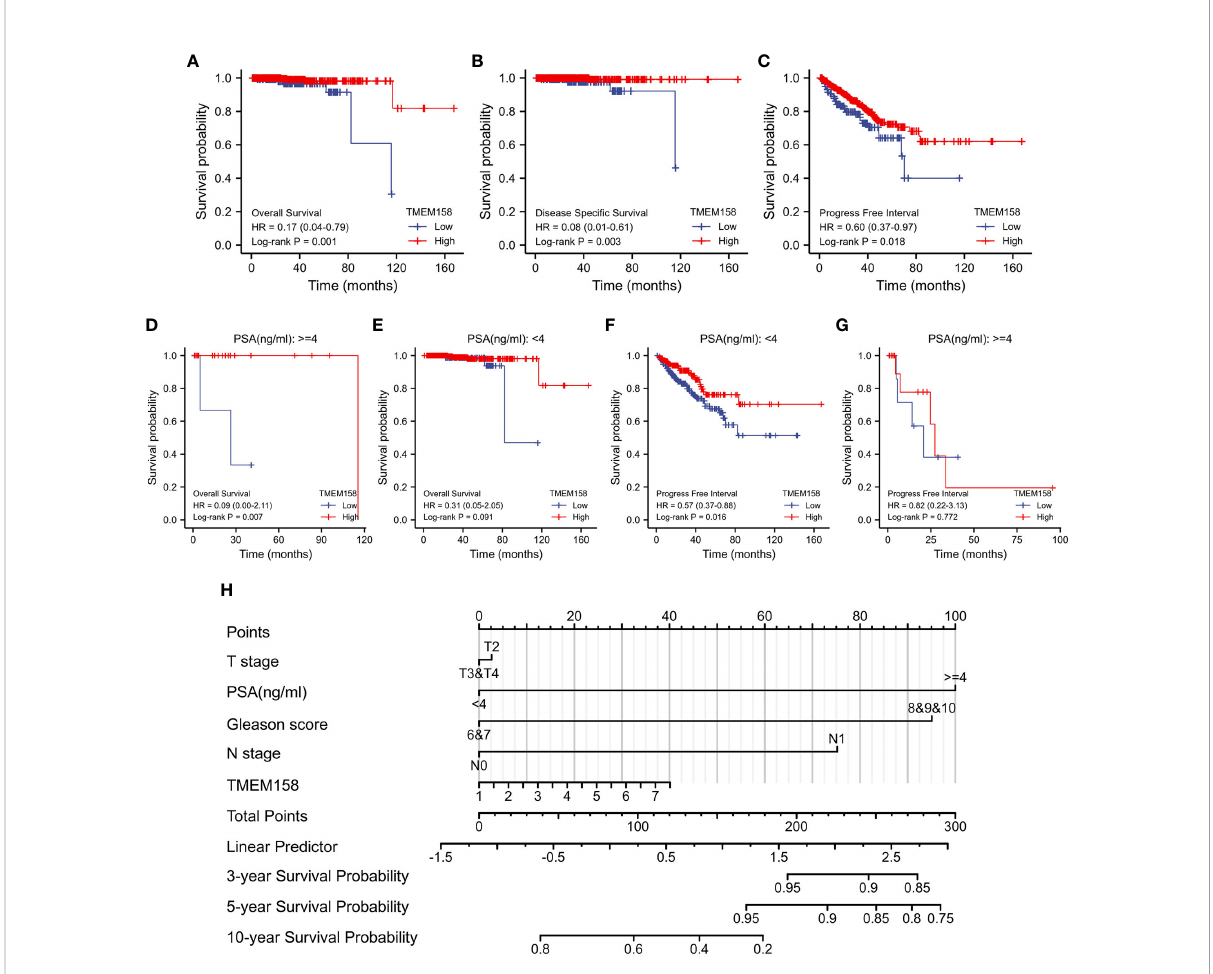
FIGURE 5 TMEM158 downregulation is associated with survival outcomes. (A – G) TMEM158 expression data were extracted from the TCGA-PRAD RNA- seq dataset, and the Kaplan-Meier survival analysis was conducted by stratifying patients using the minimum p -value approach (25). (H) TMEM158 expression levels and four critical clinicopathological parameters were utilized to generate the nomograph as a survival prediction tool (36). The concordance index is 0.743 (95% CI 0.659-0.826, log-rank test p =